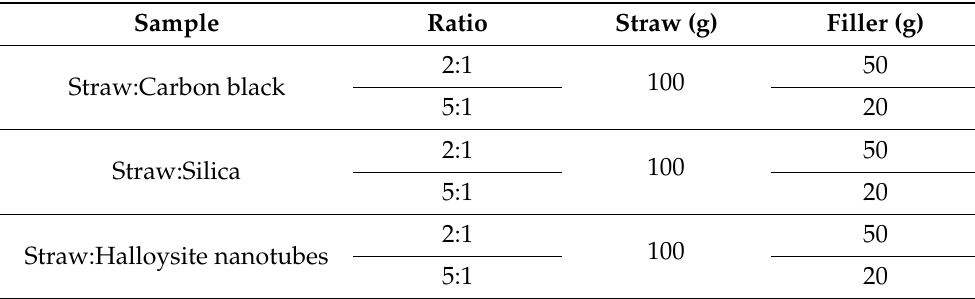
Figure 1. Scheme of straw hybridization with nano-additives. Table 2. Composition of hybrid